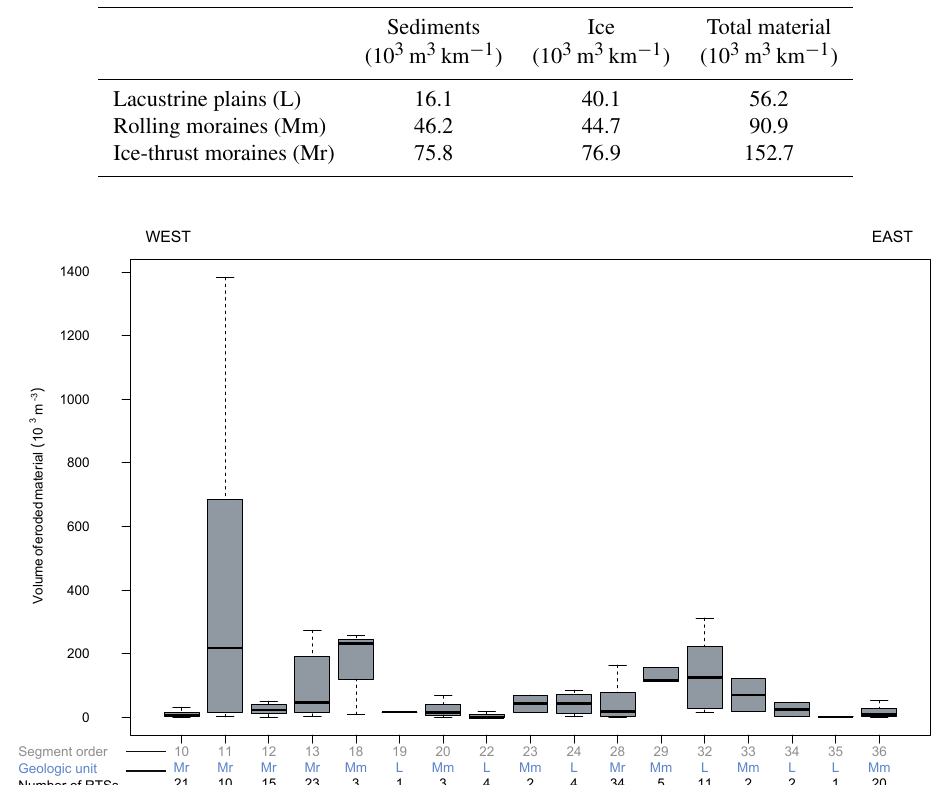
Figure 6. Box plot of volumes of eroded material (sediments and ice) per retrogressive thaw slump (RTS) for the coastal segments where RTSs occurred in 2011. Each bar corresponds to a coastal segment, following a geographic order from west on the left to east on the right. The number of the respective coastal segment is indicated in the first line on the x axis. The geologic units are indicated below the bars and referred to as L (lacustrine plains), Mm (rolling moraines), and Mr (ice-thrust moraines). The values on the lowest line of the x axis indicate the total number of RTSs per coastal